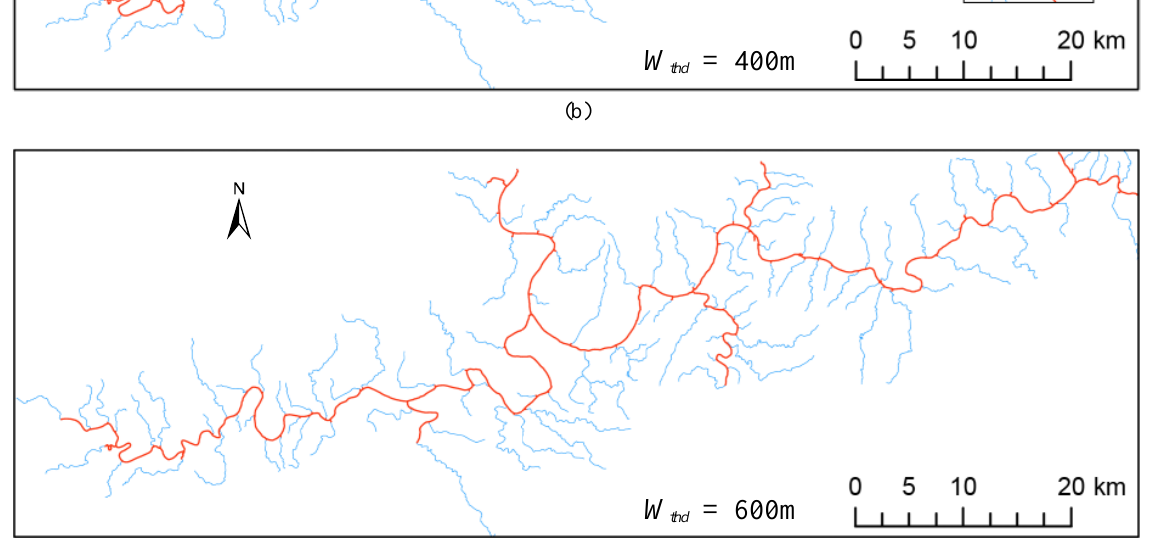
Figure 13. Progressive collapse results of the proposed method: ( a ) W thd = 300 m; ( b ) W thd = 400 m; ( c ) W thd = 600 m